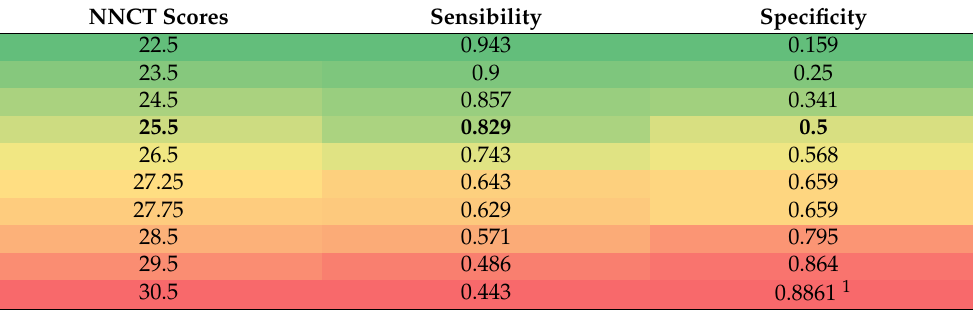
Table 2. Healthy older adults and MCI.